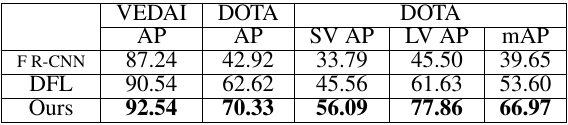
Table 1. Experimental results showing average precision (AP) and mean AP (mAP) when detecting small (SV) and large vehicles (LV) separately in percent.